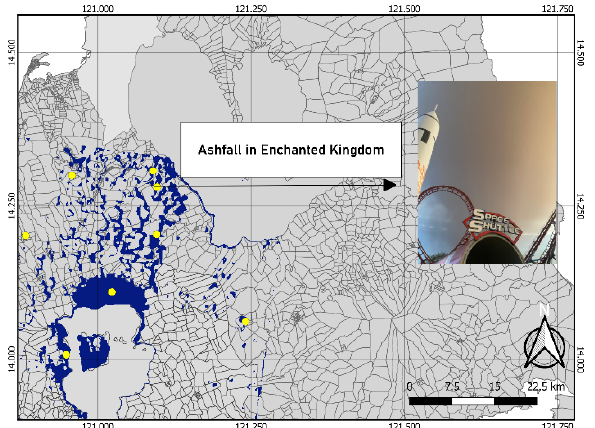
Figure 9. Geocoded tweet within the classified heavy ash reporting ashfall presence in Santa Rosa, Laguna